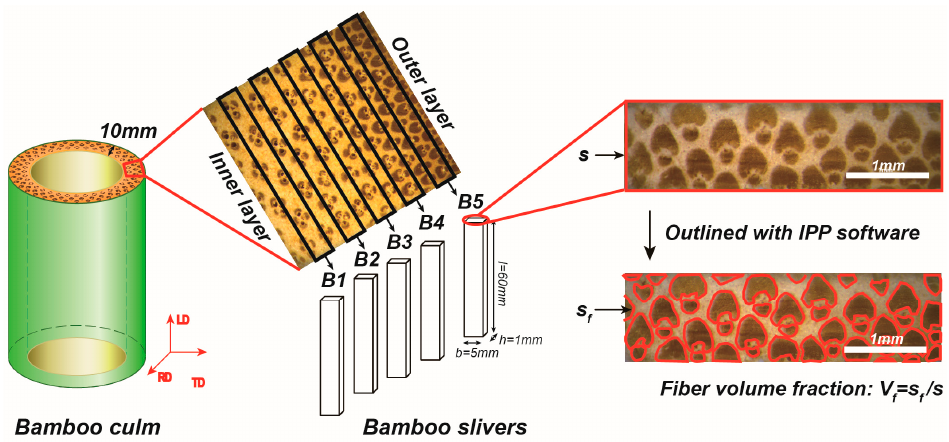
Figure 3. Schematic diagram of processing of samples and calculation of fiber volume fraction ( V f ).